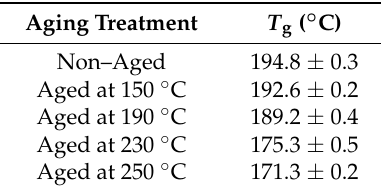
Figure 12. ( a ) DMA Metller Toledo equipment and ( b ) details of the cantilever beam configuration setup according to ASTM D7028 standard. Table 8. Average values of glass transition temperature ( T g ) of quasi-isotropic laminates aged at different temperatures for 10 days. Standard deviation is included.